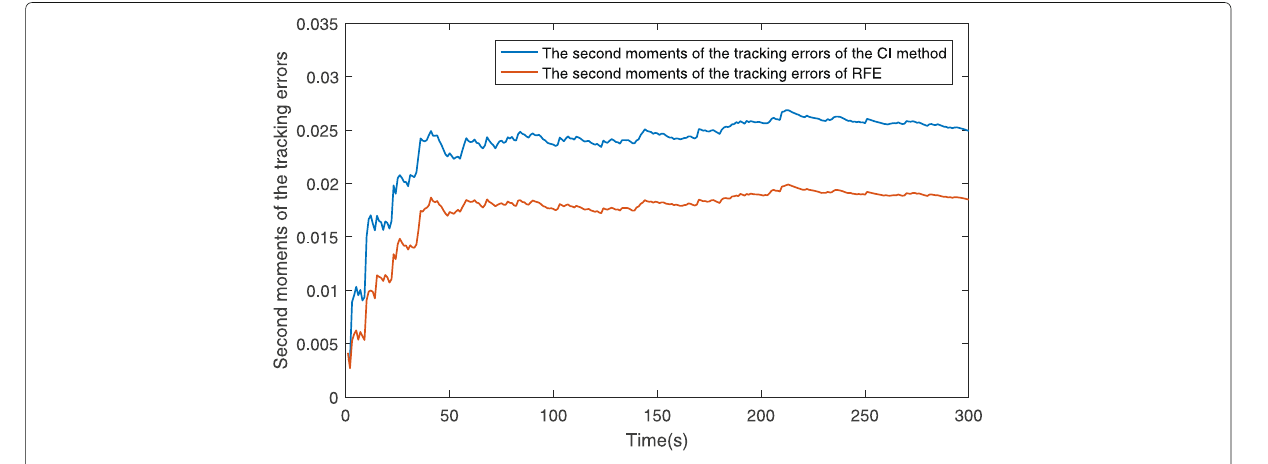
Fig. 5 The comparison of the second moments of the tracking errors with a i = 8